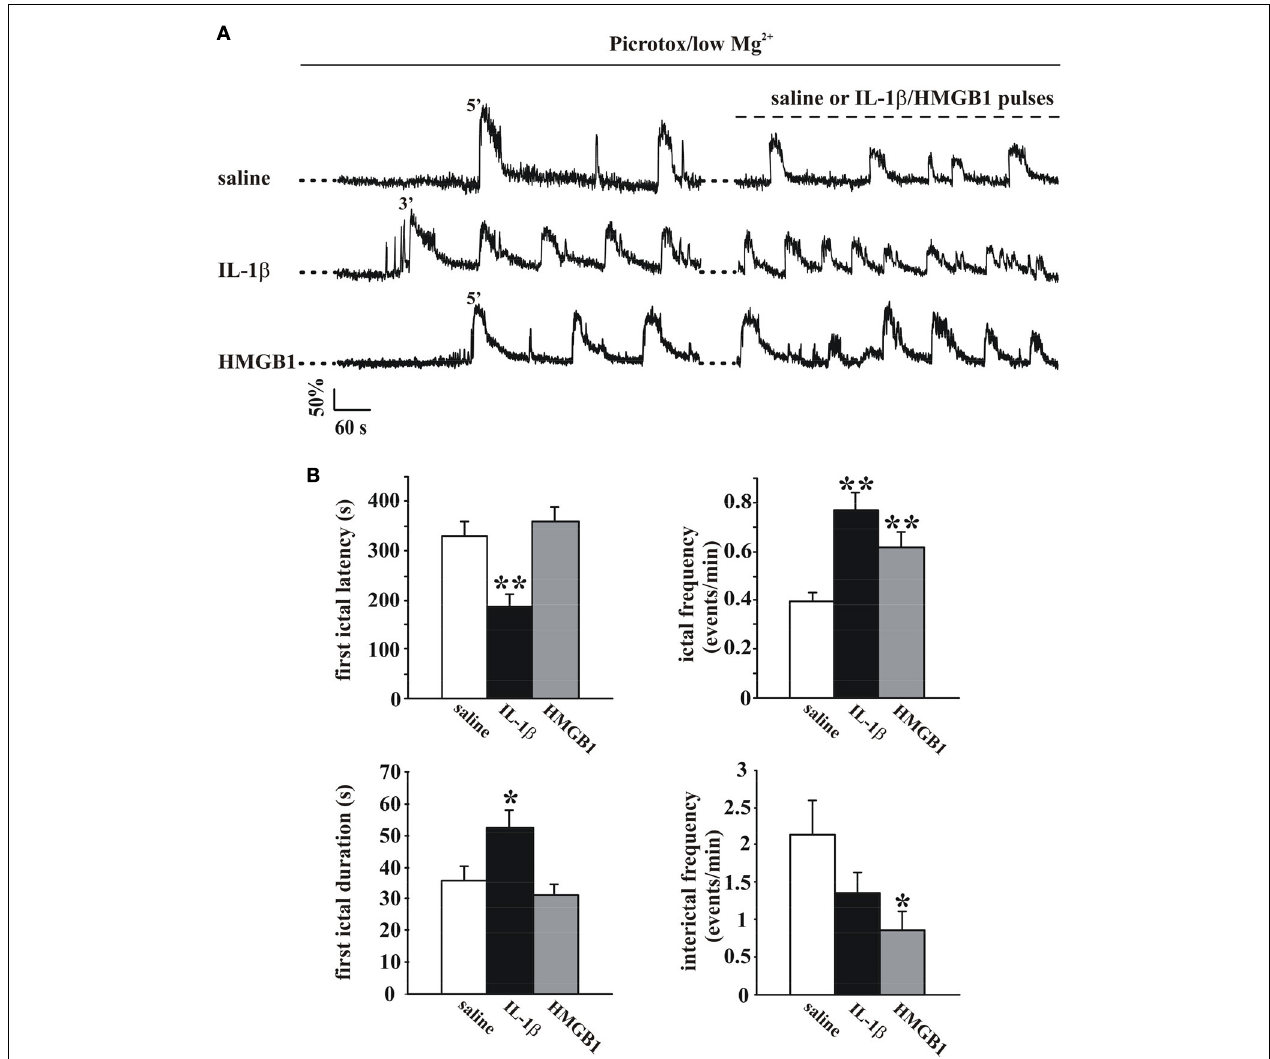
FIGURE 1 | IL-1 β and HMGB1 applications favor ictal-like event generation in the low Mg 2 + /Picrotoxin model. (A) Ca 2 + changes in representative neurons from a rat EC slices perfused with low Mg 2 + /Picrotoxin in the absence (upper trace, saline) and in the presence of IL-1 β or HMGB1 pulse applications (middle and lower traces, respectively). (B) Histograms representing the quantification of